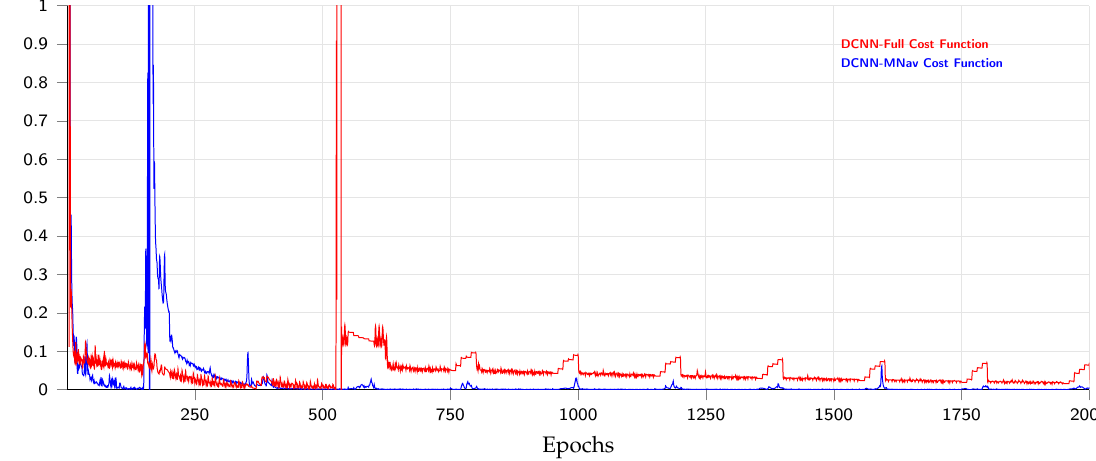
Figure 21. Deep convolutional neural network behavior with navigation meshes and the full path. Figure 22 represents the behavior of the auto-encoder (AED) training, where 5000 epochs had a precision of 95% with 20 test samples. This experiment, similar to the evaluation before, showed two behaviors with all nodes created by A ∗ and with the navigation mesh reducing the number of nodes in the